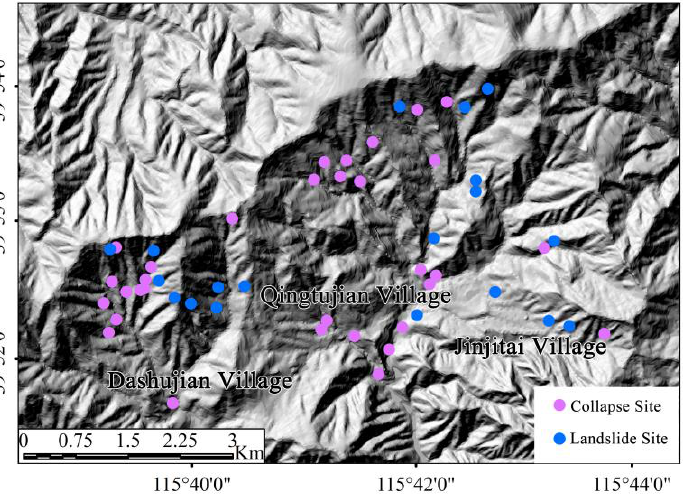
Figure 3. Collapses and landslides distributed in the study area. The base map is shaded relief map. Table 2. Information of collapses and landslides in the study area.